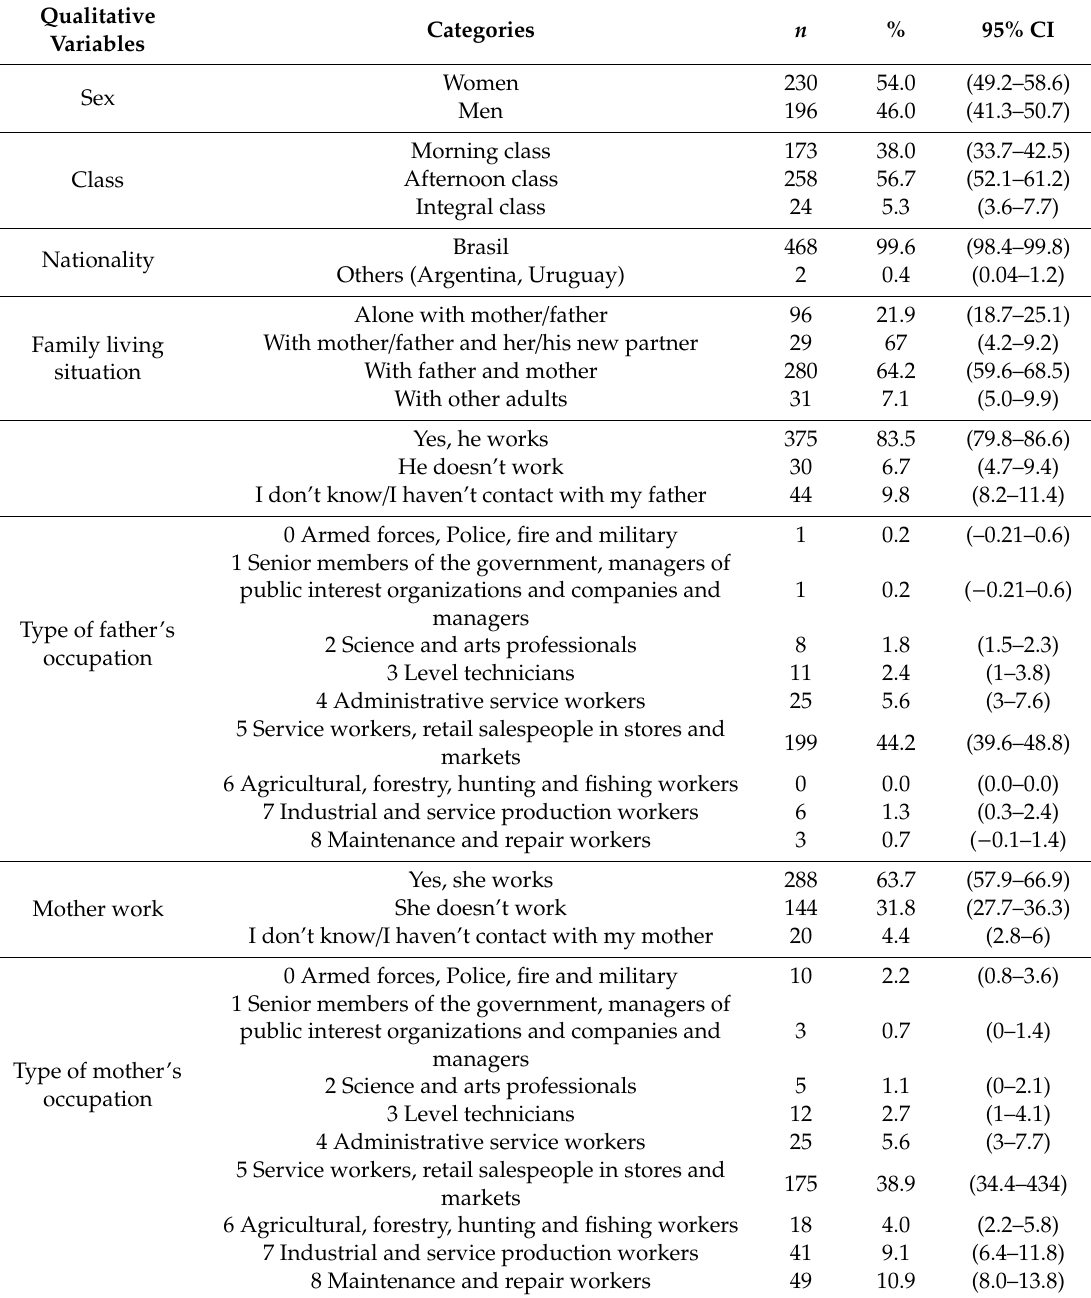
Table 1. Sociodemographic and characteristics of the